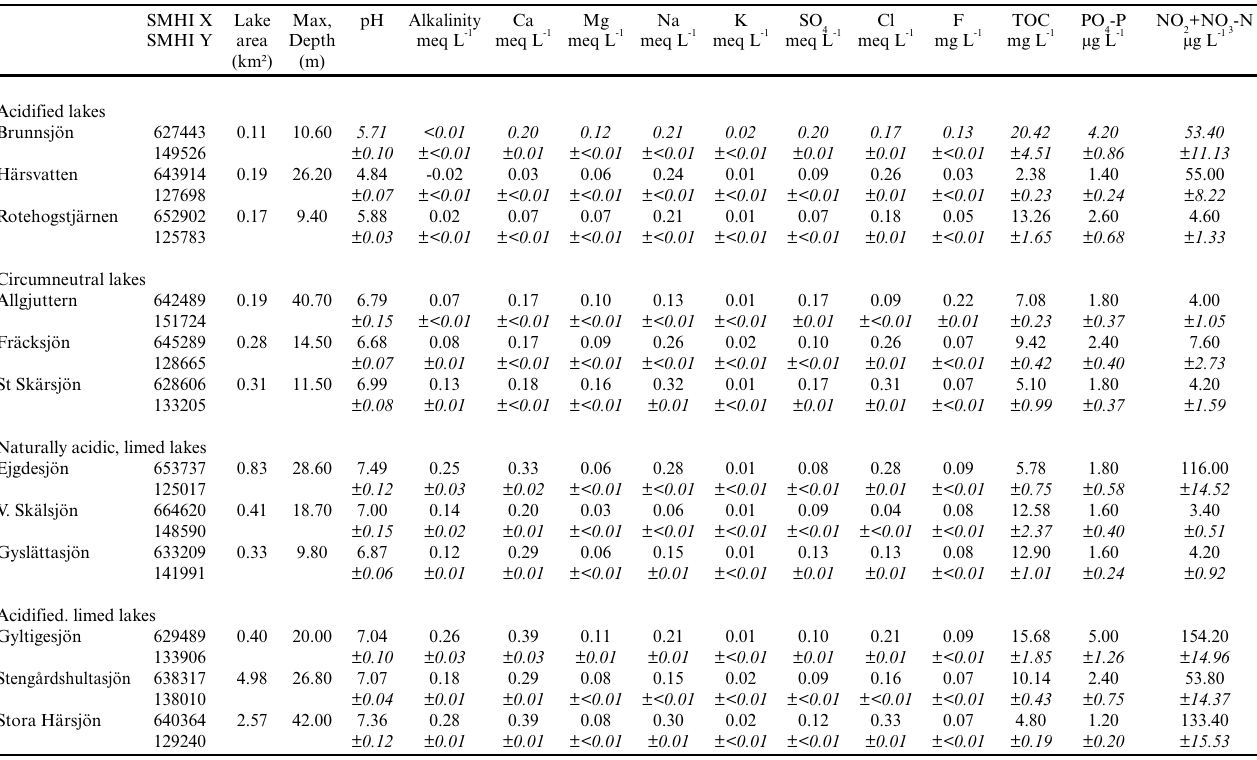
Table 1. Morphological and selected water chemistry characteristics of lakes included in the study. Values represent the interannual mean values based on summer values (August) ± 1 standard error (italic fonts; n = 5) for the time period 2000-2004. SMHI = Swedish Meteorological and Hydrological